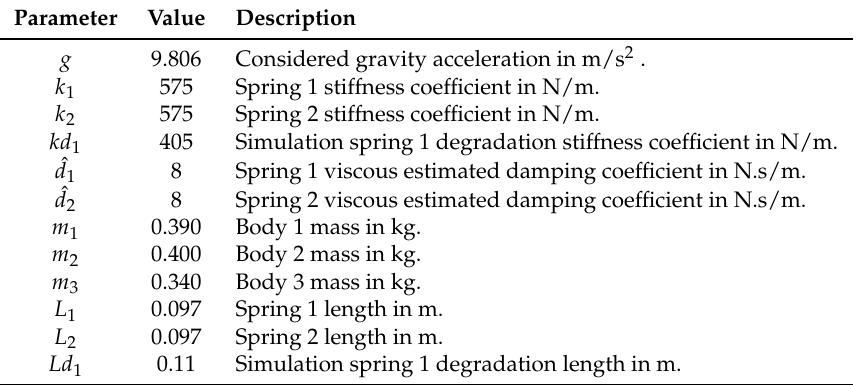
Table 15. Parameters and variables of the Analytical